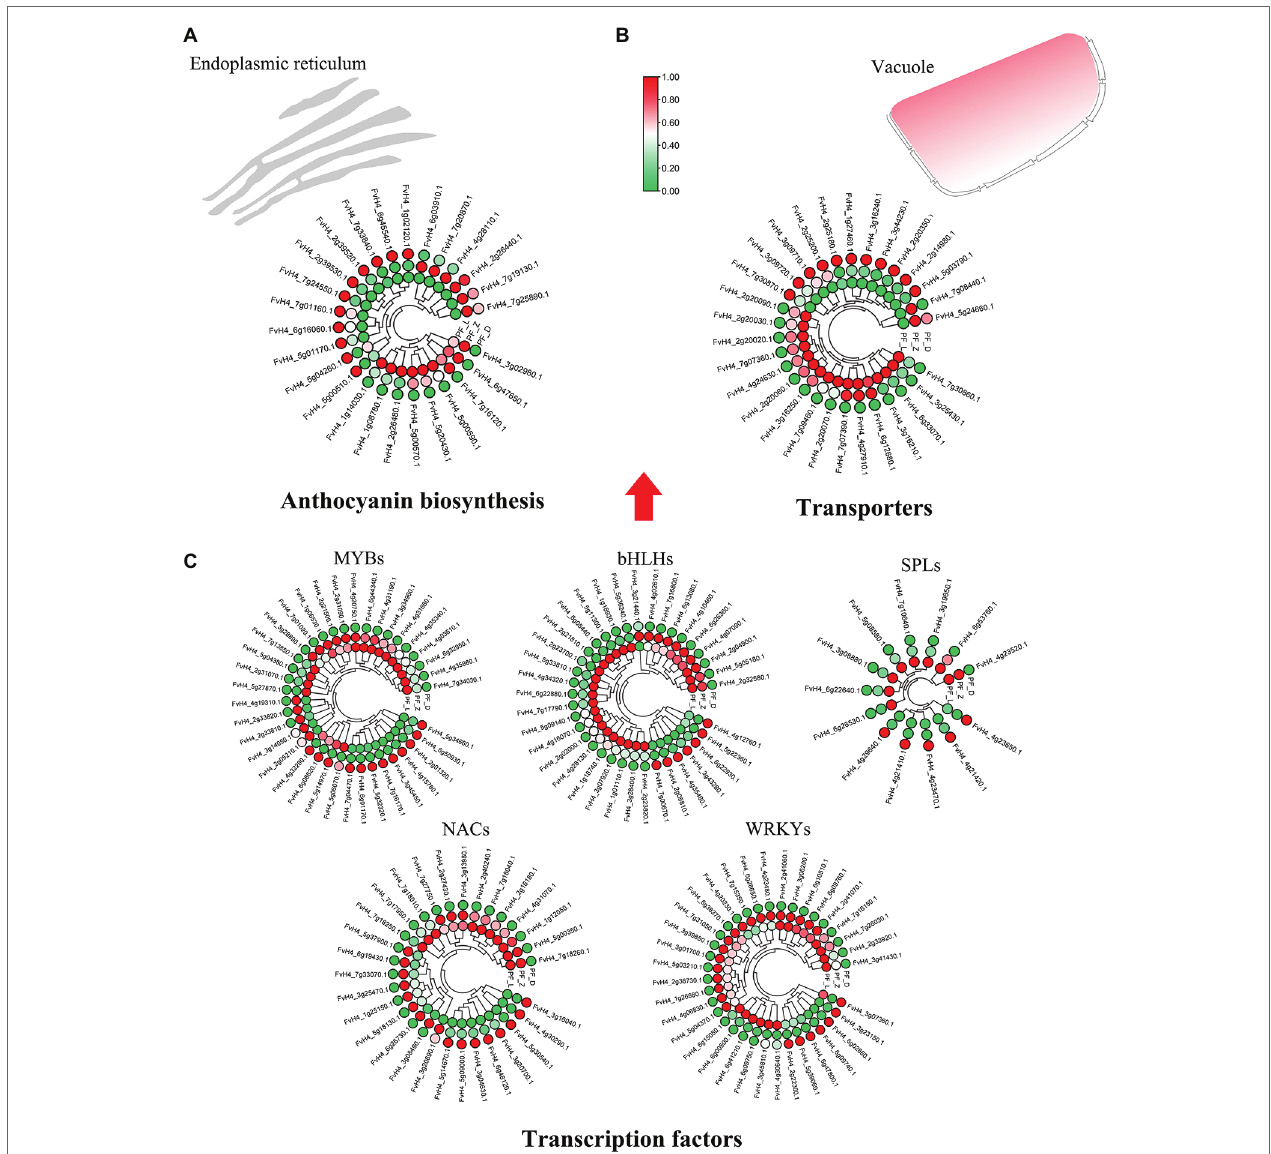
FIGURE 3 | Heatmaps showing the expression patterns of the differentially expressed genes involved in anthocyanin biosynthesis. (A) Differentially expressed structural genes of the anthocyanin biosynthesis pathway. (B) Differentially expressed transporters involved in anthocyanin biosynthesis. (C) Differentially expressed transcription factors, including MYBs , bHLHs , SPLs , NACs , and WRKYs , which regulate anthocyanin